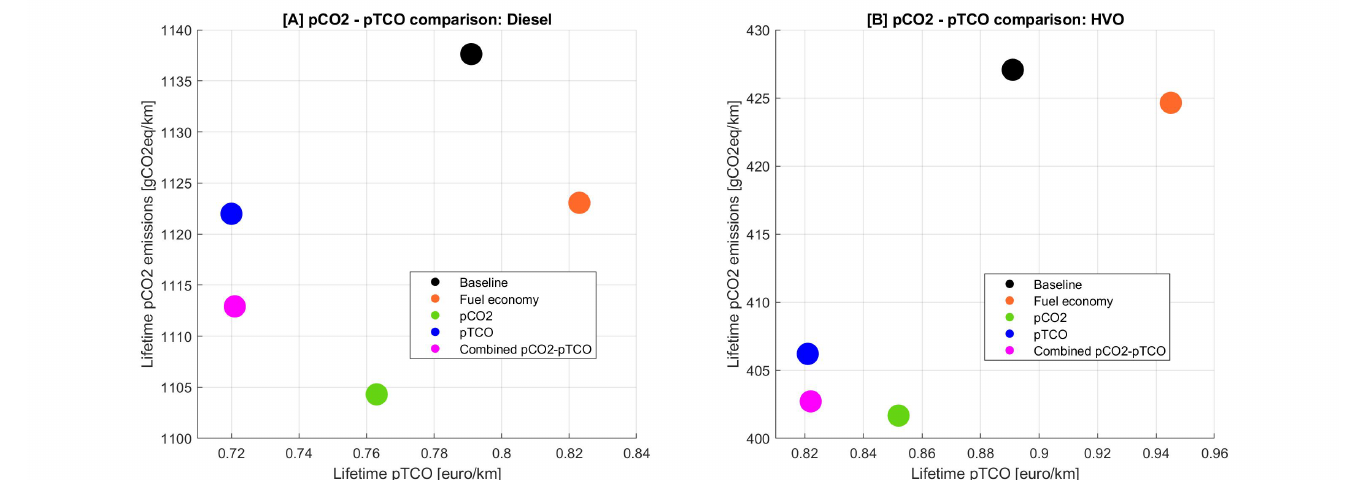
Figure 10. Comparison of lifetime powertrain cost ( pTCO ) and carbon footprint ( pCO 2 ) reductions for various series-HEV optimal sizing configurations including baseline, fuel economy, pCO 2 minimi- sation, pTCO minimisation and pCO 2 − pTCO combined minimisation solutions for ( A ) diesel and ( B ) HVO-fuelled